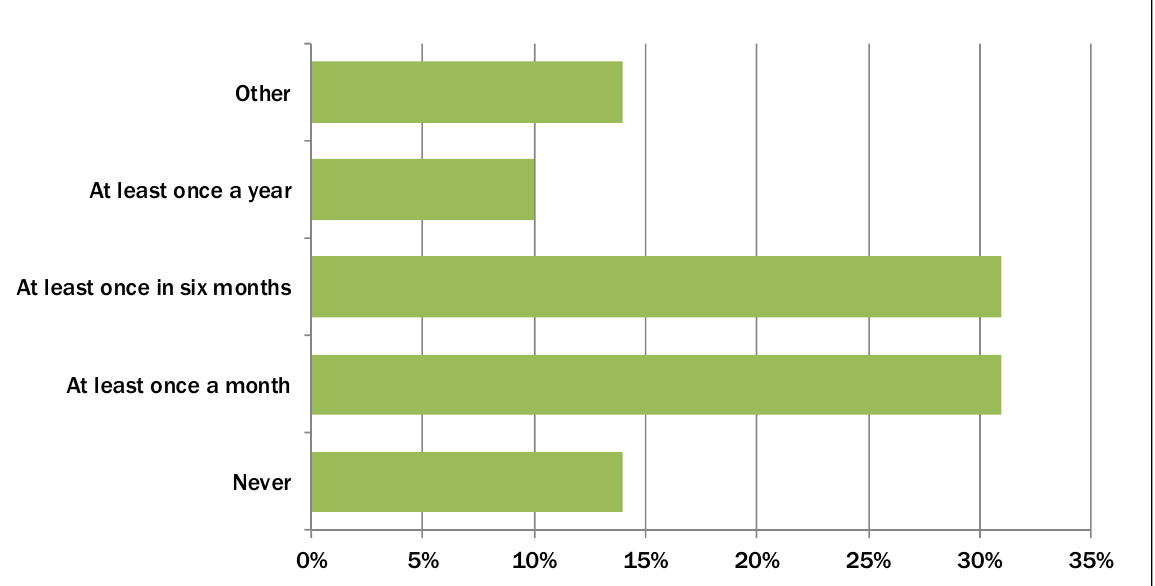
Figure 3. Percent of Nonprofit Organizations (NPOs) Hosting Meetings with Community Members by Frequency of